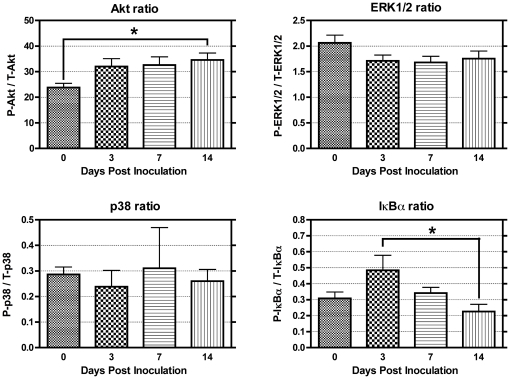
Signal transduction changes in liver due to C. rodentium infection.The phosphorylated/total mean fluorescence intensity (MFI) ratios were determined for liver lysates (5 µg total protein) harvested from animals over the course of C. rodentium infection. Average Akt activation was significantly increased at 14 DPI with comparable elevations at 3 and 7 DPI missing statistical significance. Elevations were observed in IκBα phosphorylation, particularly in mice with hepatic necrosis, demonstrating statistical significance as a group versus 14 DPI livers. ERK1/2 and p38 failed to demonstrate significant changes over the course of C. rodentium infection in livers (One-way ANOVA with Tukey's multiple comparison test: * P<0.05, ** P<0.01, *** P<0.001). Data presented as mean ± SEM.